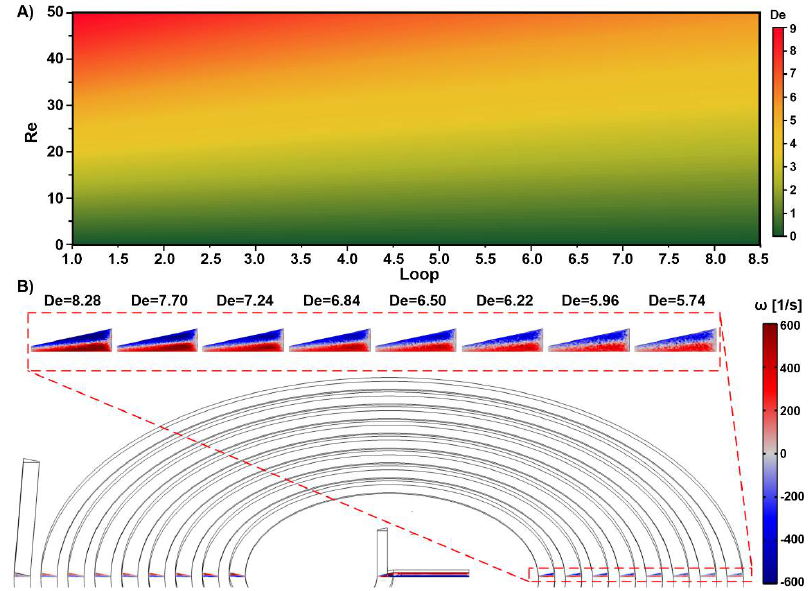
Figure 5. Mixing parameters evaluated at the final loop of SM3 in Re = 0.001–50. ( A ) Mixing index variations and pressure drop changes achieved by altering flow rates; ( B ) Concentration distribu- tion, vorticity intensity, and fluid streamlines at the final loop of the nominated design for the se- lected flow conditions.